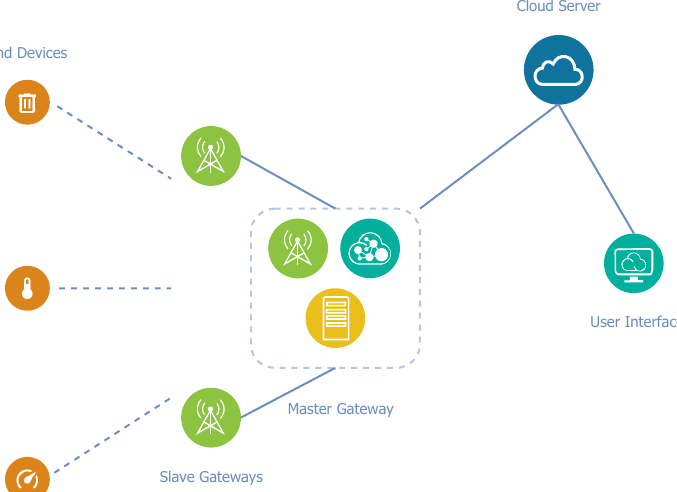
Figure 4. Diagram of network architecture B.